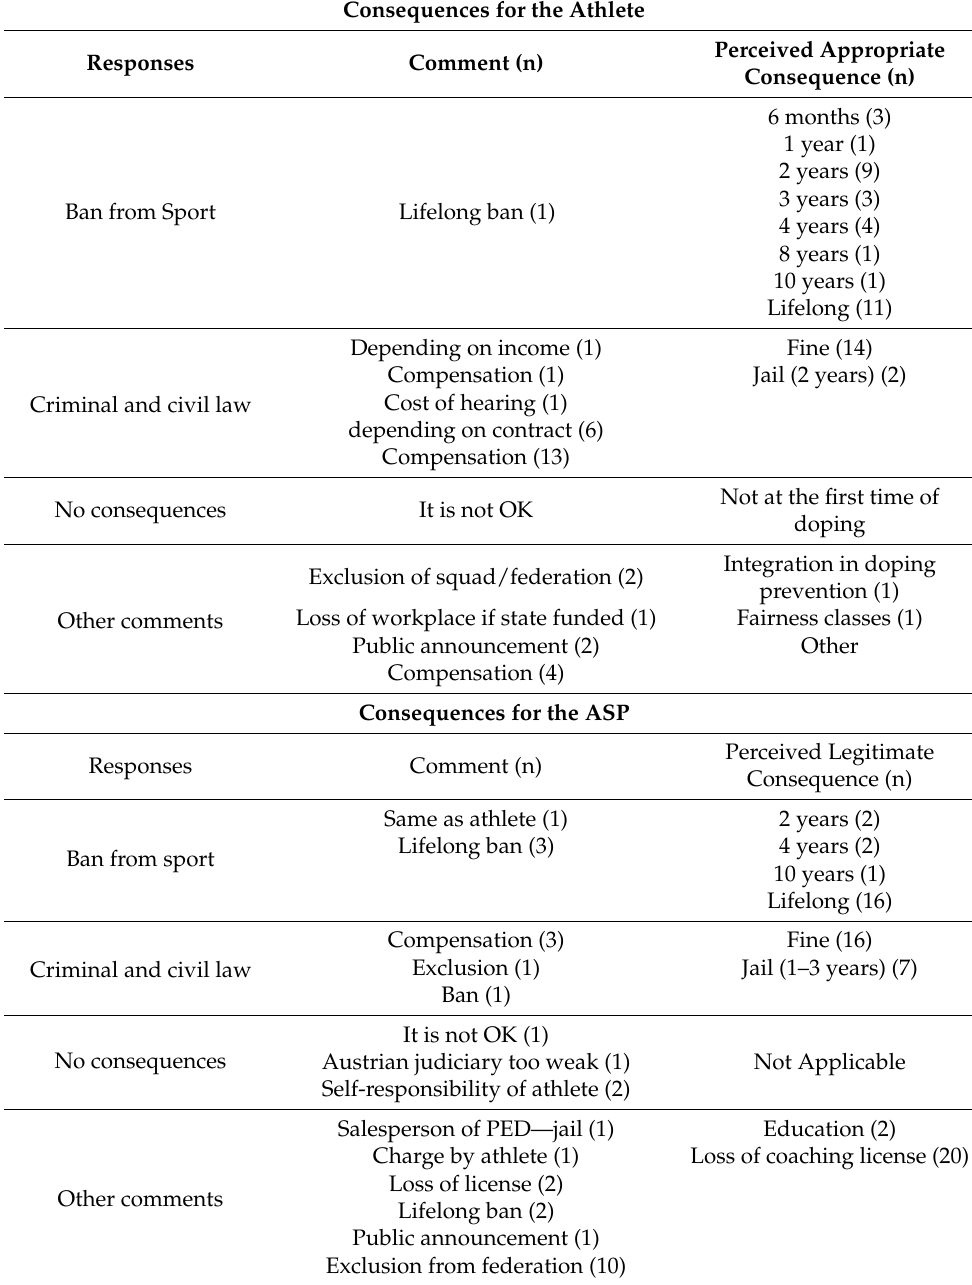
Table 2. Responses regarding consequences the athlete and ASP in the case study had to